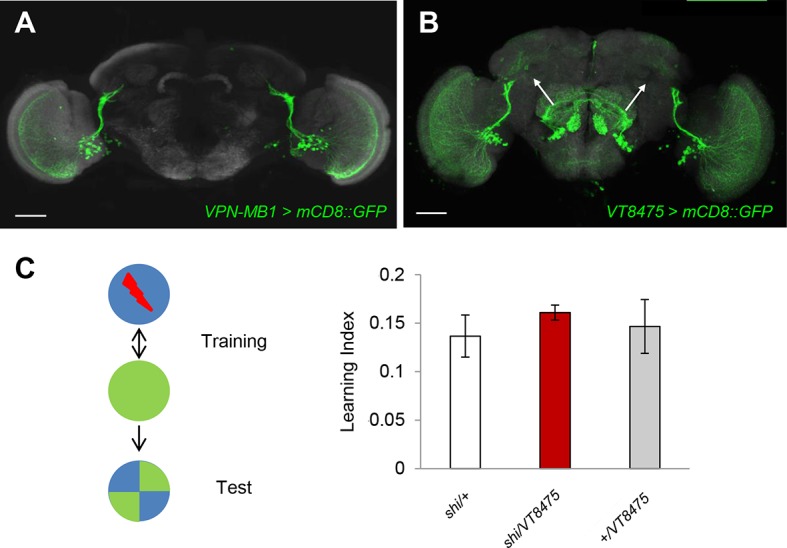
The blockade of similar VPNs without vAC connection does not impair color discrimination learning.(A and B) MB425B-GAL4 (A) and VT008475-GAL4 label VPN-MB1 and similar VPNs that do not extend to the vAC (arrows). Scale-bars represents 50 µm. (C) Blocking output of neurons labeled by VT008475-GAL4 does not impair color learning (one-way ANOVA, p>0.05), n = 8.